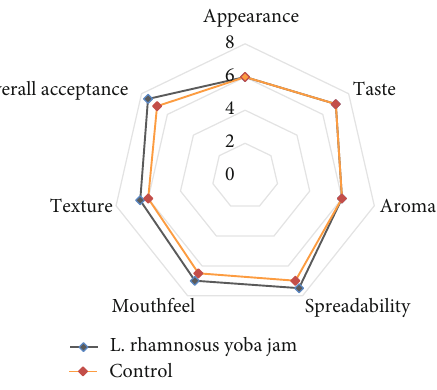
Figure 7: Preference test on jam inoculated with L. rhamnosus and control